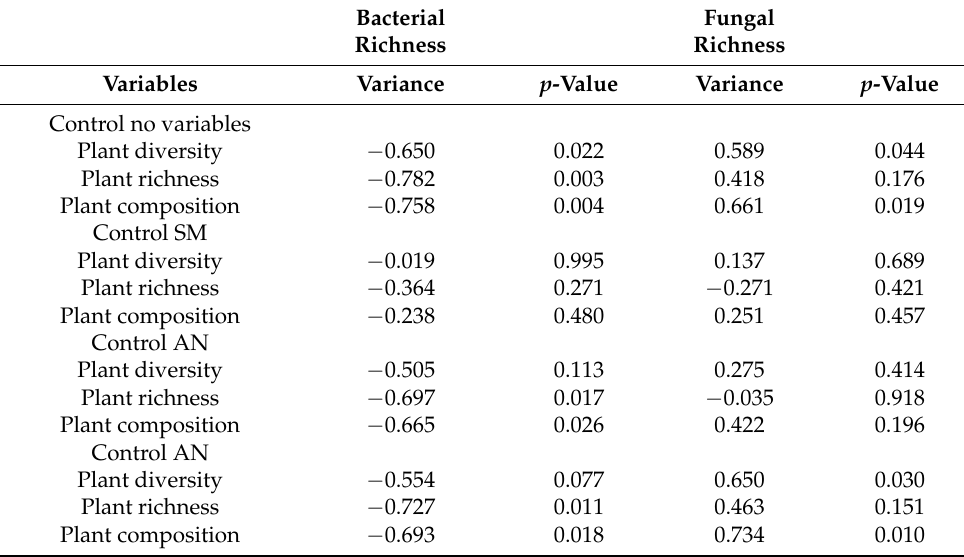
Table 3. Partial correlations between bacterial or fungal richness and plant community after control soil moisture (SM), available nitrogen (AN) and available phosphorus (AP) in 0–20 cm soil depth of